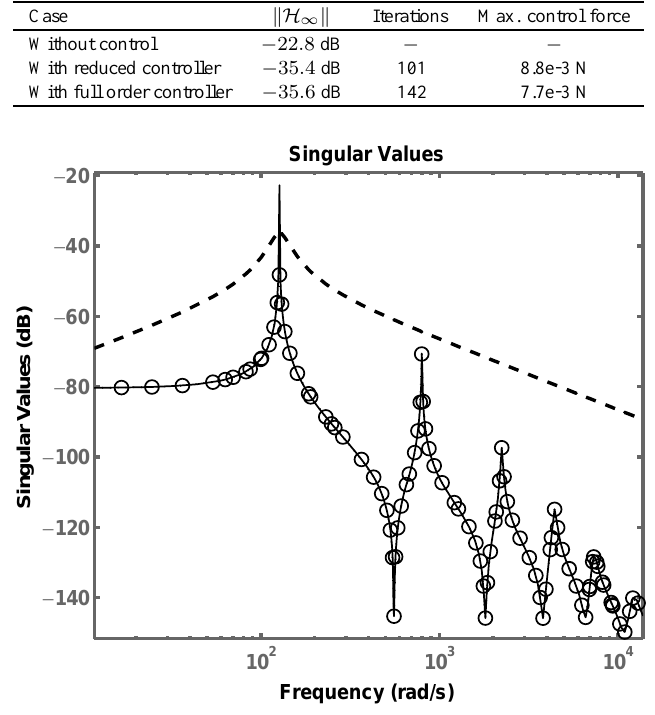
Fig. 7. Singular value diagrams. Continuous line – system without control. Dotted line – closed loop disturbance to control signal. Circles – closed loop disturbance to displacement. Full order